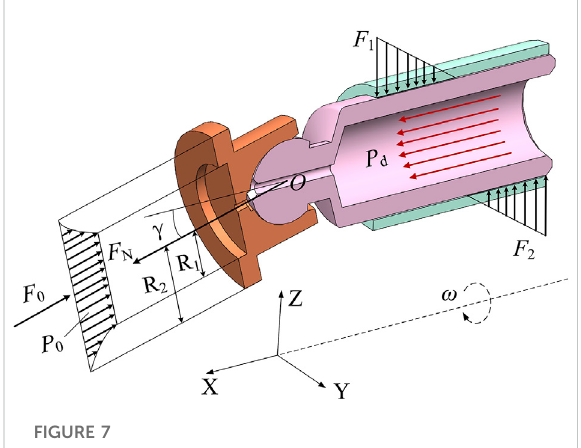
FIGURE 7 Force analysis of the slipper and plunger assembly.